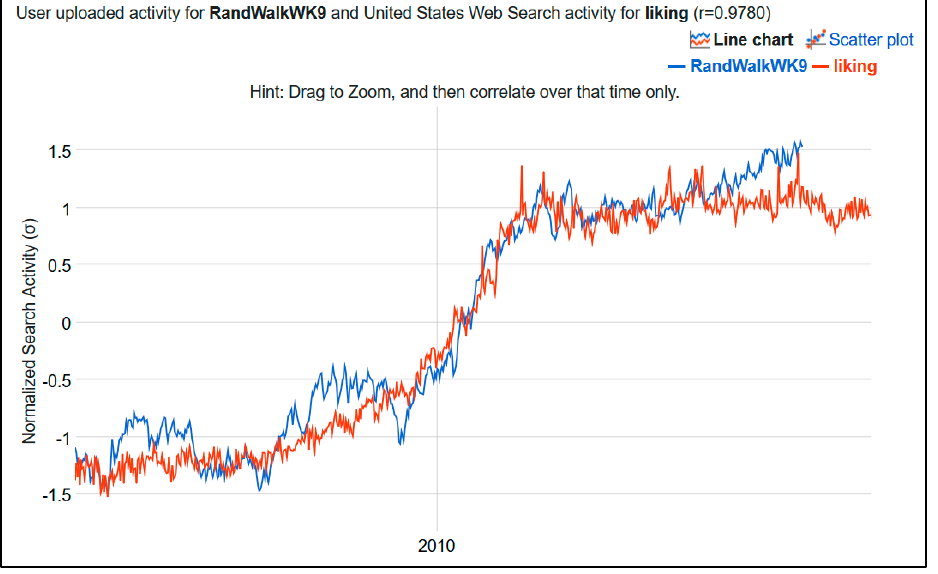
Figure 3. Screenshot of identified spurious correlation from Google Correlate. RandWalkWK9 is a random walk variable generated by adding successive standard normal draws to generate a weekly time series. The time frame for the weekly time series is from January 2004 through January 2016.